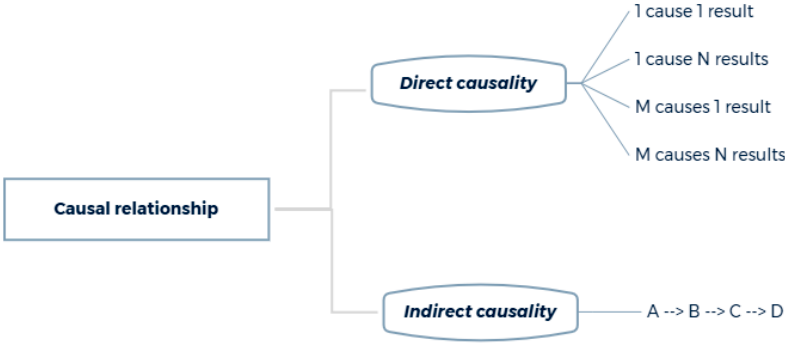
Figure 16. Direct and indirect causal relationships [174]